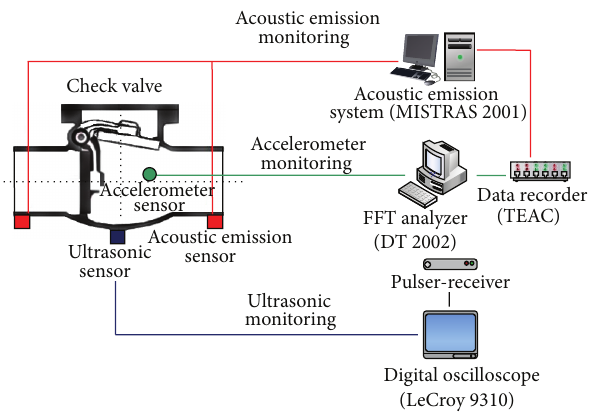
Figure 4: The schematic diagram for condition monitoring test of the check valve [60].